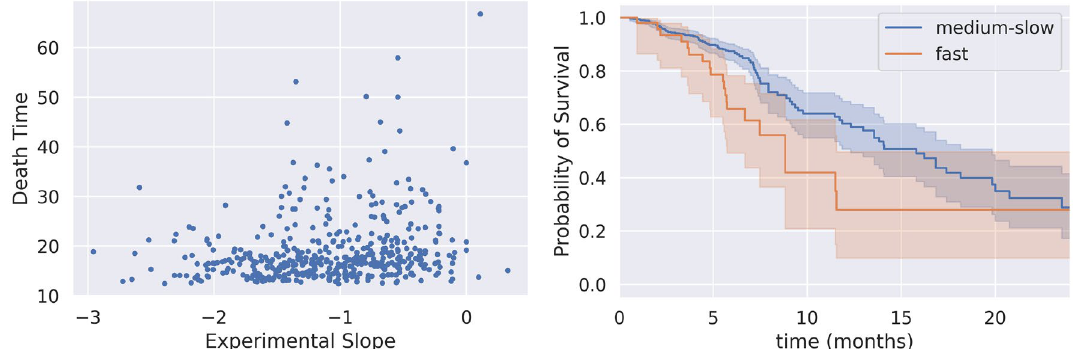
Figure 5. Slope and survival. Left: Scatterplot of the experimental slope between months 3 and 12 against the time-to-death of 458 patients. Right: Kaplan–Meier curves for fast and medium-slow progressing patients in the test set. Fast and medium-slow progressors were 21 and 105, respectively. Times start from month 12 after the first